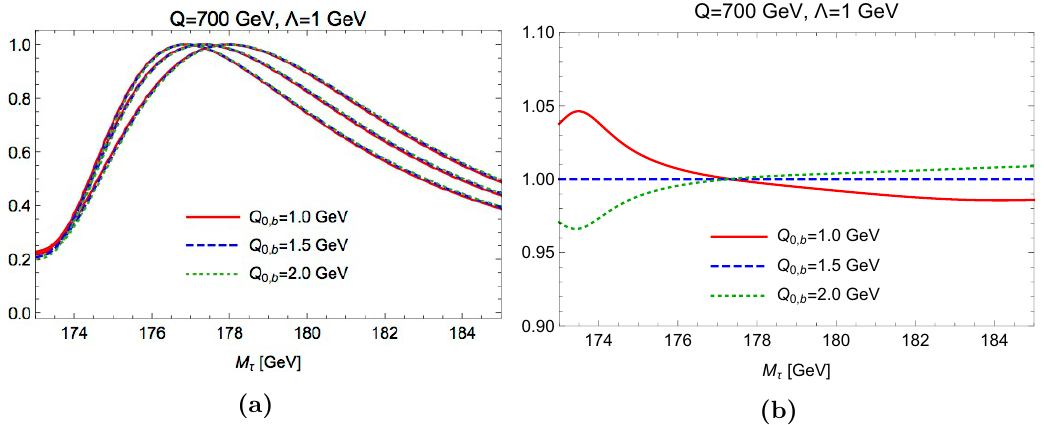
Figure 9. Parton level rescaled thrust for top quarks with m t = 173 GeV and Q = 700 GeV in the peak region generated by Herwig 7 and smeared with a soft model shape function with smearing parameter (cid:3) = 1 GeV, see section 2.3. Displayed are simulation results for production stage shower cuts Q 0 = 1 GeV (right set of curves), Q 0 = 1 : 5 GeV (middle set of curves) and Q 0 = 2 GeV (left set of curves) and decay stage shower cuts Q 0 ;b = 1 GeV (solid red curves), Q 0 ;b = 1 : 5 GeV (dashed blue curves) and Q 0 ;b = 2 GeV (dotted green